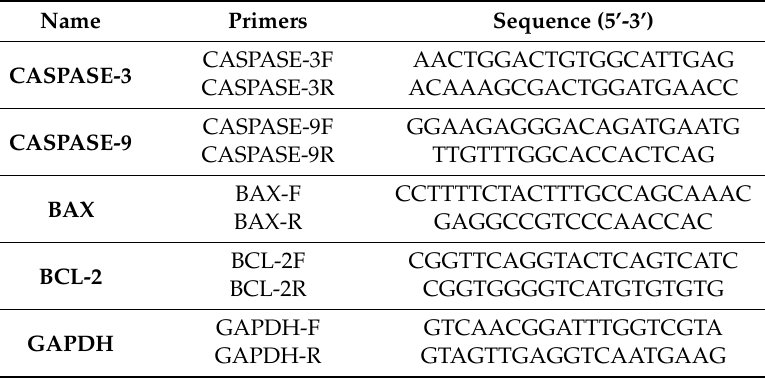
Table 2. Primers used for